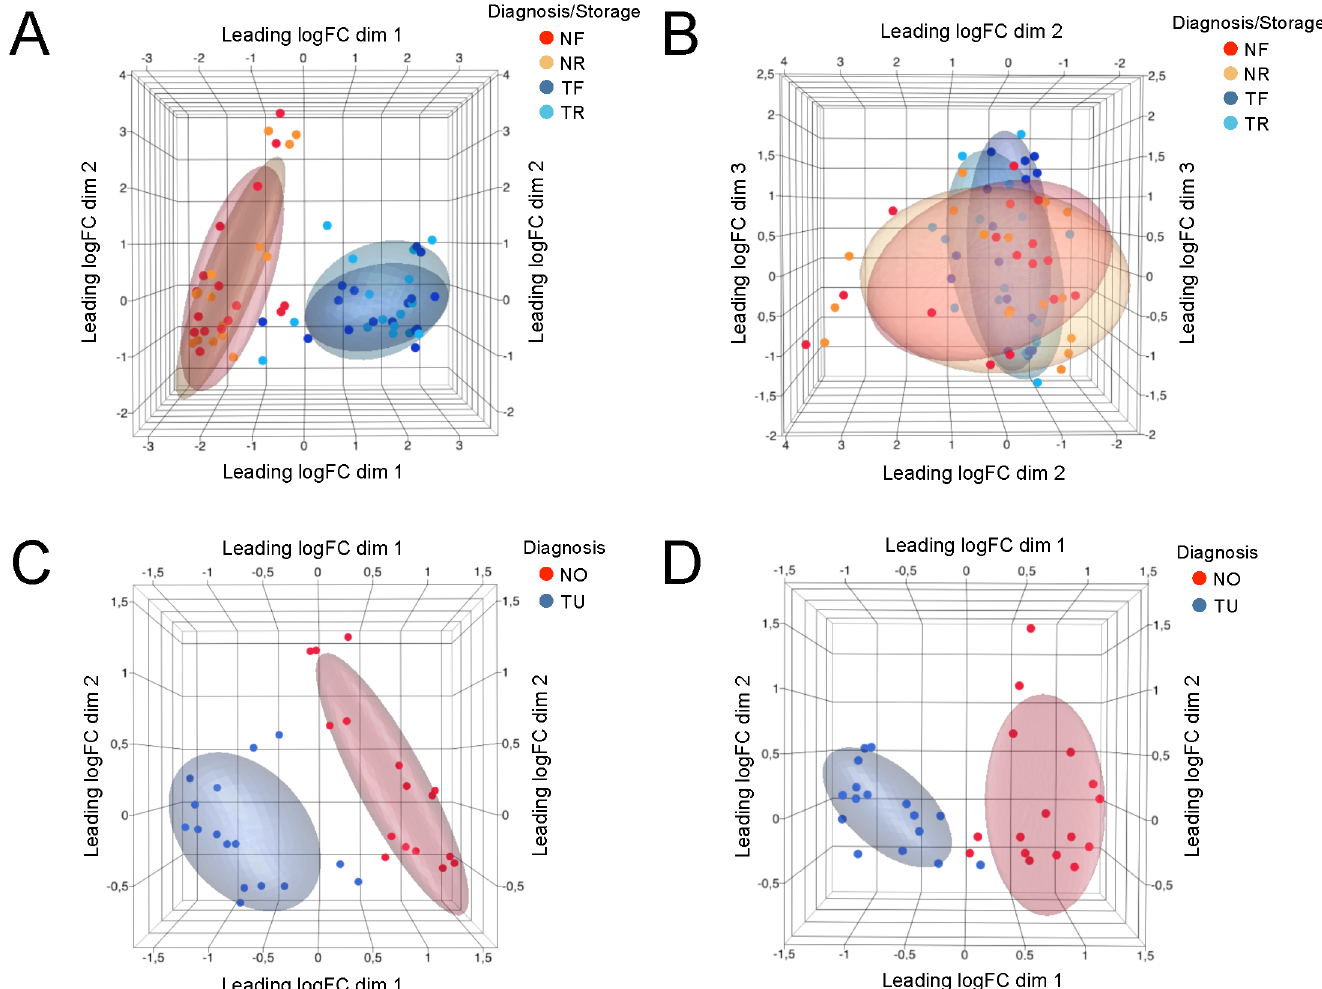
Fig 1. Multidimensional scaling (MDS) analysis of gene expression data. MDS analysis based on all commonly detected genes shows that samples segregate by diagnosis (A) and not by storage condition (B). Distances correspond to leading log-fold-changes between each pair of samples. MDS based on differentially expressed genes demonstrates less within-group variance compared to MDS with all detected genes in the RNAlater 1 (C) and FFPE (D) datasets. NF : Normal , FFPE; NR : Normal , RNAlater 1 ; TF : Tumor , FFPE; TR : Tumor , RNAlater 1 . NO = Normal; TU = Tumor